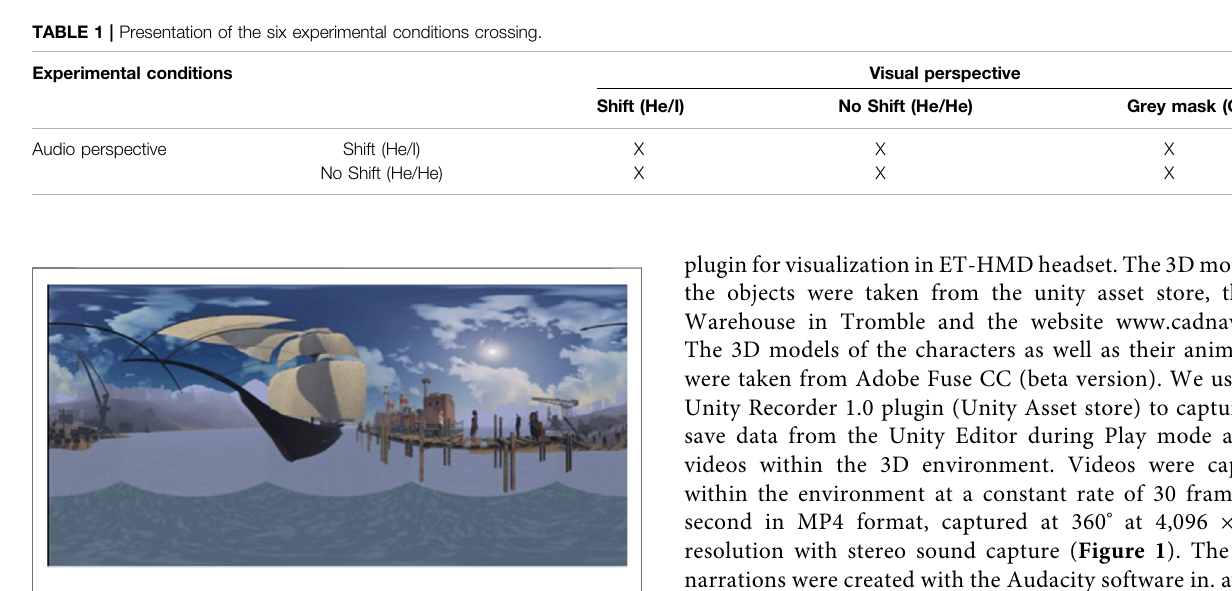
FIGURE 1 | Start of the 360 ° VR scene related to the narration cited in example.